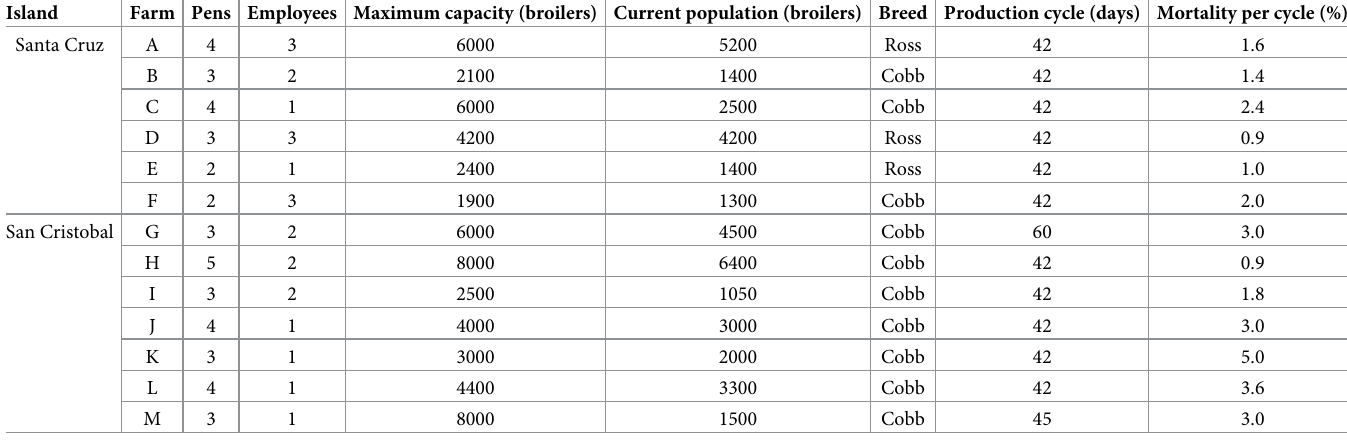
Table 1. Study broiler farms on Santa Cruz Island and San Cristobal Island, Galapagos: July 2017.